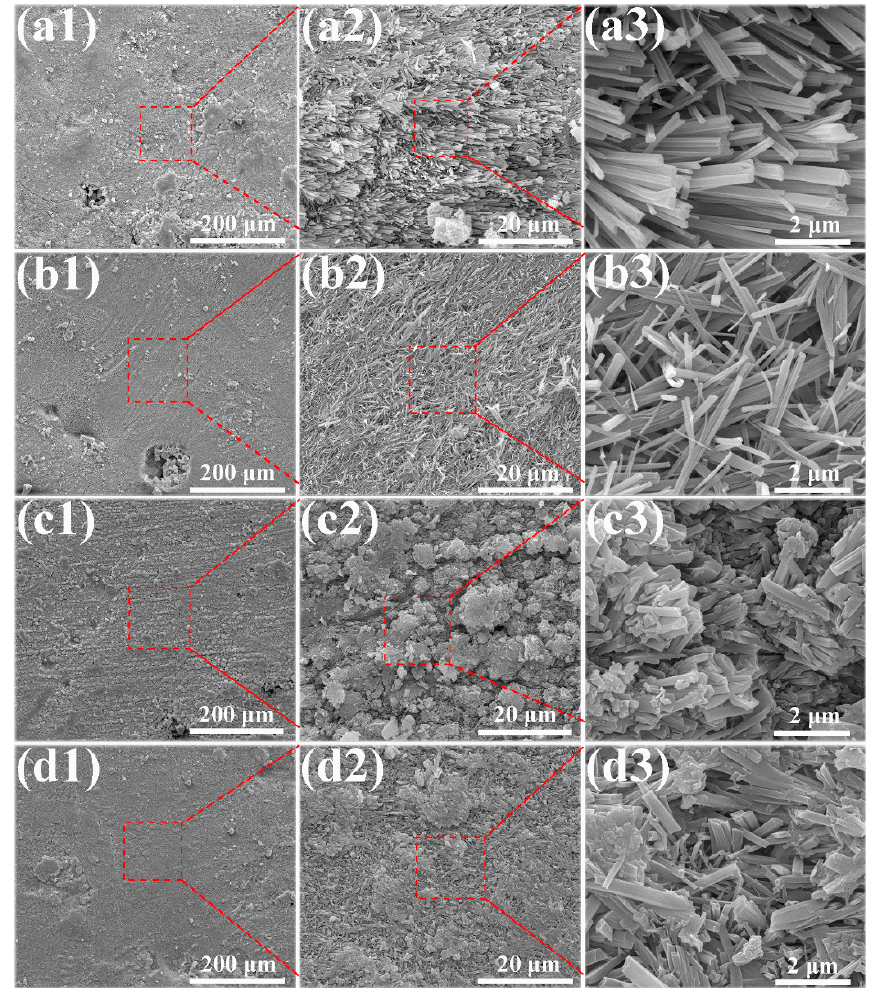
Figure 4. SEM morphologies of the as-prepared surfaces of different samples. ( a1 ), ( a2 ) and ( a3 ) pure MOC; ( b1 ), ( b2 ) and ( b3 ) MOC-10FD; ( c1 ), ( c2 ) and ( c3 ) MOC-20FD; ( d1 ), ( d2 ) and ( d3 ) MOC-30FD.